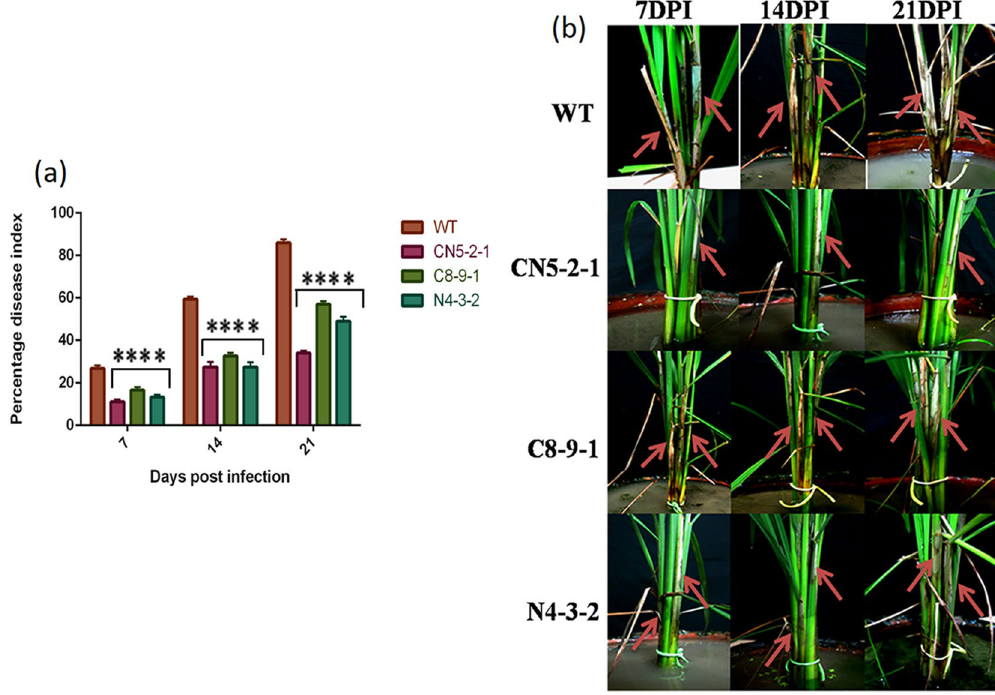
Figure 6. Whole plant bioassay of T 2 transgenic and wild type (WT) plants with sheath blight fungus, R . solani . ( a ) Percent Disease Index (PDI) value in T 2 transgenic plants with respect to wild type control at 7, 14 and 21 dpi (days post inoculation). The values represent as the mean ± SE (n = 15). ( b ) Representative images showing typical sheath blight symptoms development on rice tillers of T 2 transgenic (CN5-2-1, C8-9-1, and N4-3-2) and non transformed wild type control. Pictures were taken at 7, 14 and 21 dpi. Red arrows indicate sheath blight